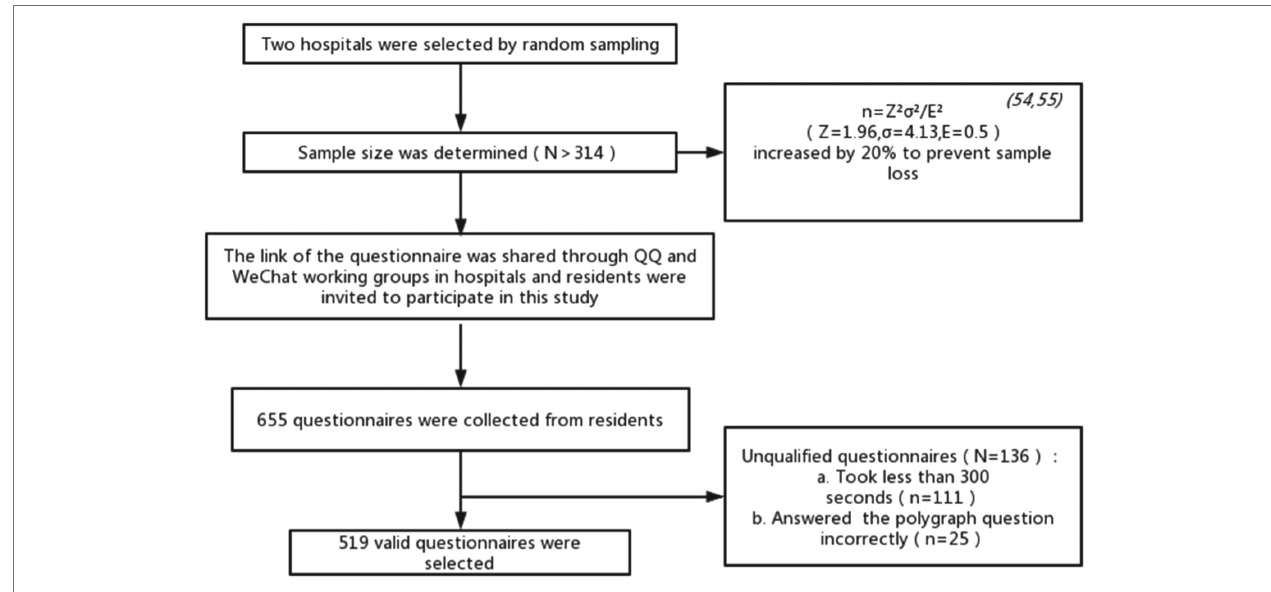
FIGURE 2 | Participant sampling and recruitment